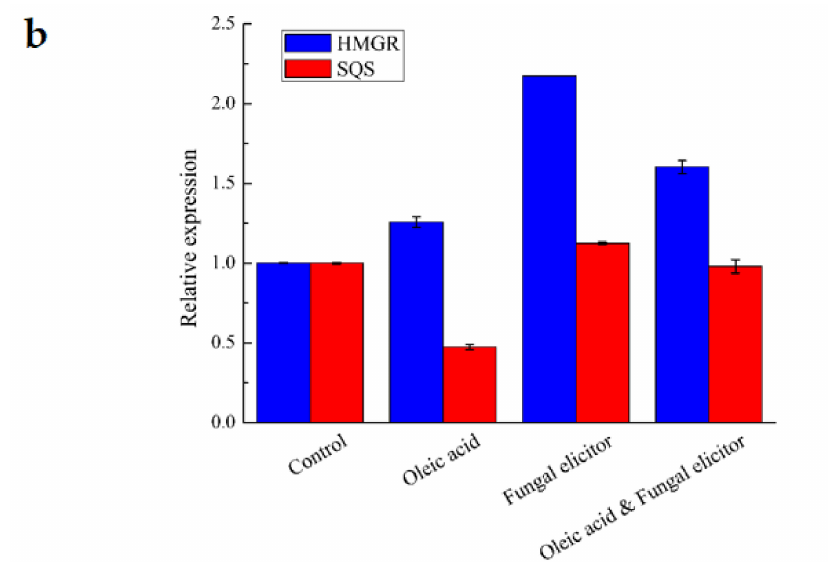
Figure 6. ( a ) BA biosynthetic pathway in I. obliquus . Dashed lines represent steps made up of several enzyme reactions. HMG-CoA, hydroxy-3-methylglutaryl-Coenzyme A; HMGS, HMG-CoA synthase; HMGR, HMG-CoA reductase; MVD, mevalonate-5-pyrophosphate decarboxylase; IPP, isopentenyl- pyrophosphate; FPS, farnesyl pyrophosphate synthase; FPP, farnesyl diphosphate; SE, squalene epox- idase; SQS, squalene synthase; OSC, oxidosqualene cyclase; LUP, lupeol synthase. ( b ) Quantitative real-time PCR analysis of genes involved in the biosynthesis pathway of